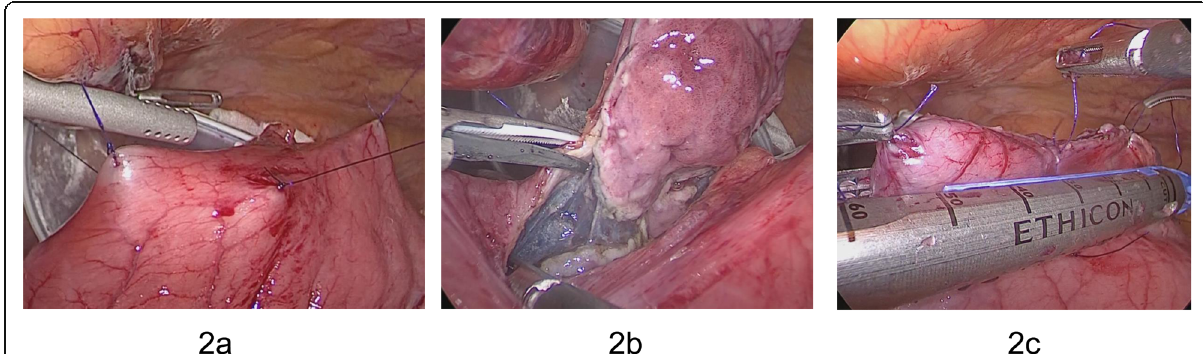
Fig. 2 The ESD technique was performed around the tumor, and the seromuscular layer was intentionally perforated ( a ). An ultrasonically